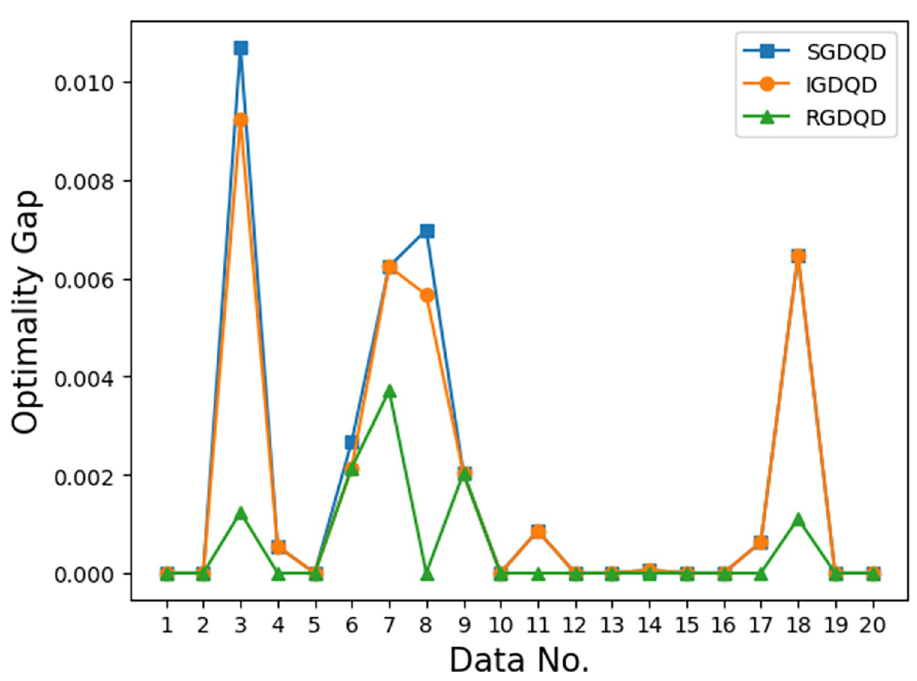
Fig 10. Comparison of optimality gaps for Q = 150000.